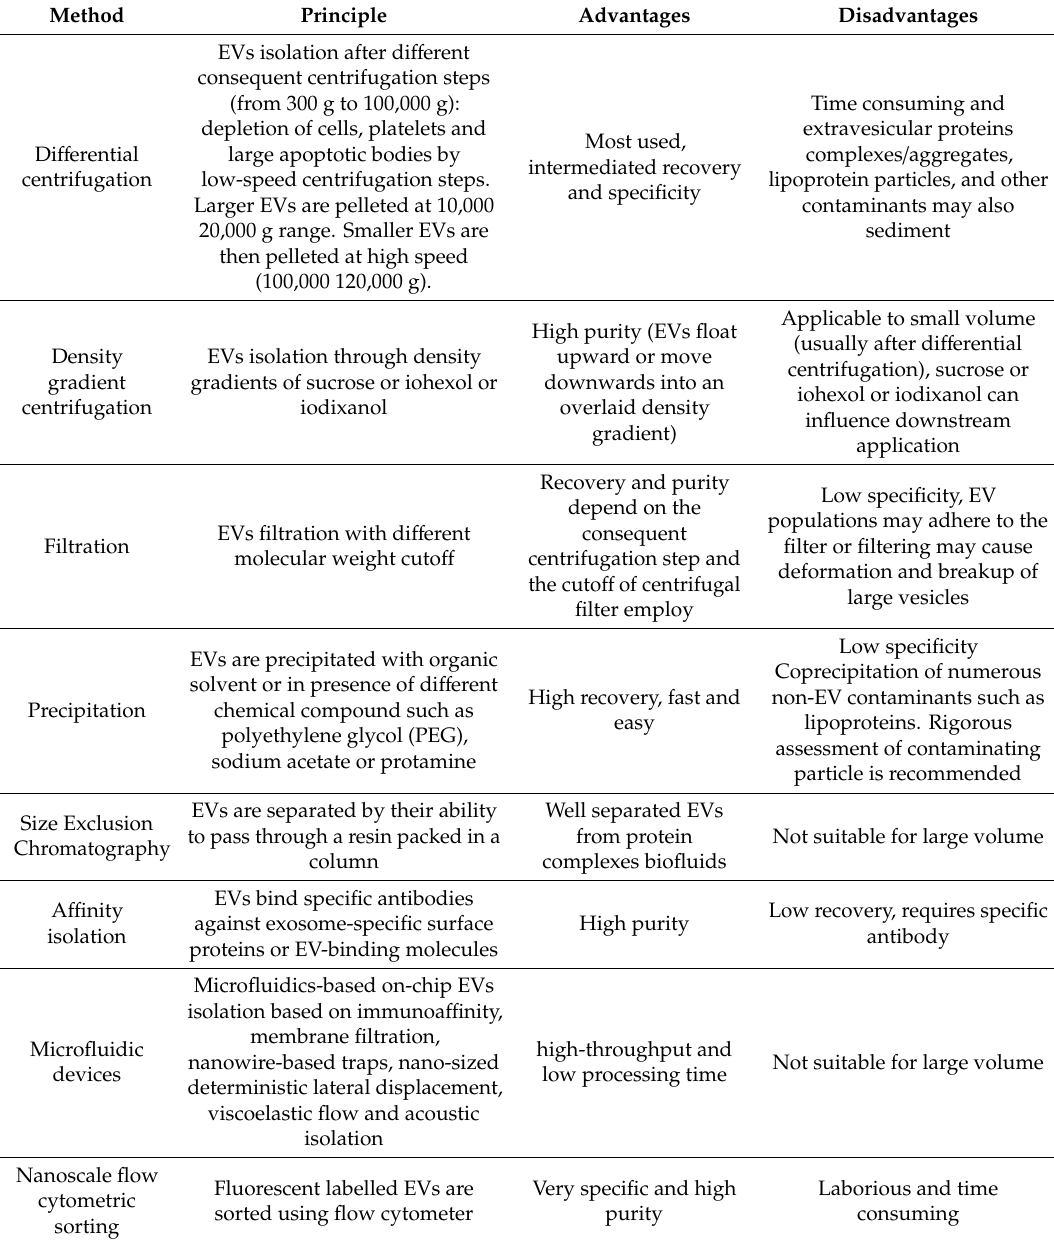
Table 1. Summary of EV isolation techniques and main advantages (pros) and disadvantages (cons) for di ff erent